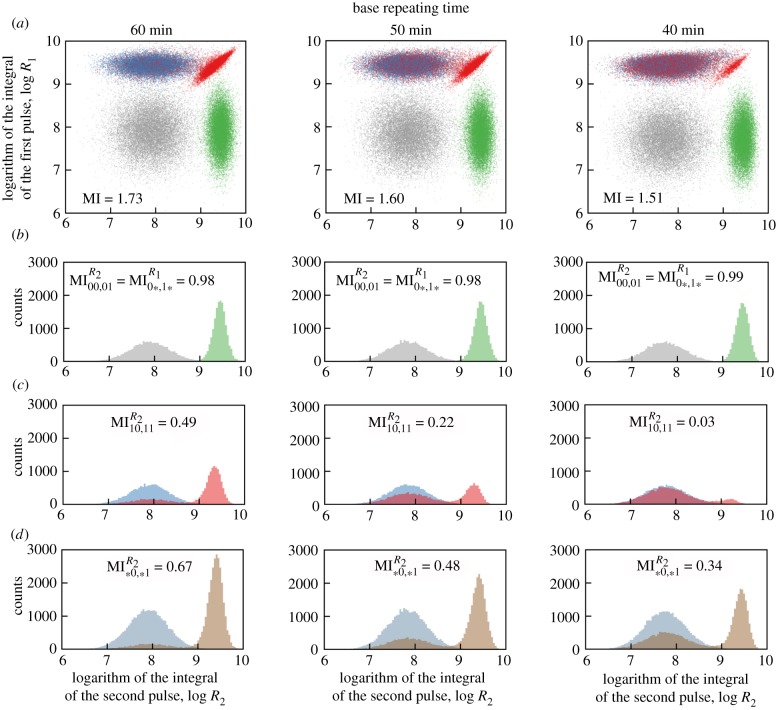
ERK responses to four binary sequences: 00, 01, 10 and 11 for three base repeating times. (a) Scatter plots of R1, R2 for all sequences (grey 00, green 01, blue 10, red 11), based on 16 000 simulations for each sequence. (b) Histograms of R2 when the first pulse has amplitude 0 (grey 00, green 01). (c) Histograms of R2 when the first pulse has amplitude 1 (blue 10, red 11). (d) Histograms of R2 independently of the first pulse amplitude (blue *0, brown *1). In all scatter plots, MI denotes the mutual information calculated for two-dimensional distributions; in all histograms, MI denotes the mutual information calculated based on two shown one-dimensional distributions.